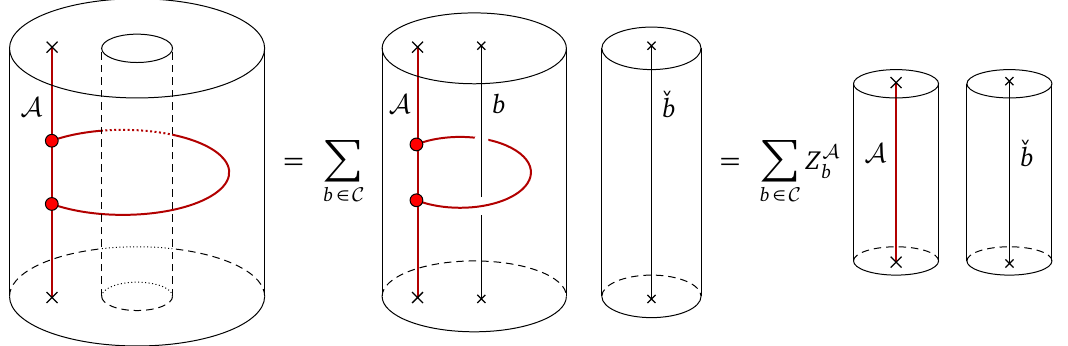
Figure 8: Factorization of the T 2 × I partition function of the gauged theory T . Left: the T 2 × I geometry (the upper and lower faces are indentified in all pictures) with the network of algebra object A inserted. Middle: two solid tori, obtained by inserting the completeness of states at some point along I . We recognise the projector P Right: The S T 2 × S T 2 partition function of T . This picture is the non-Abelian analog of Figure